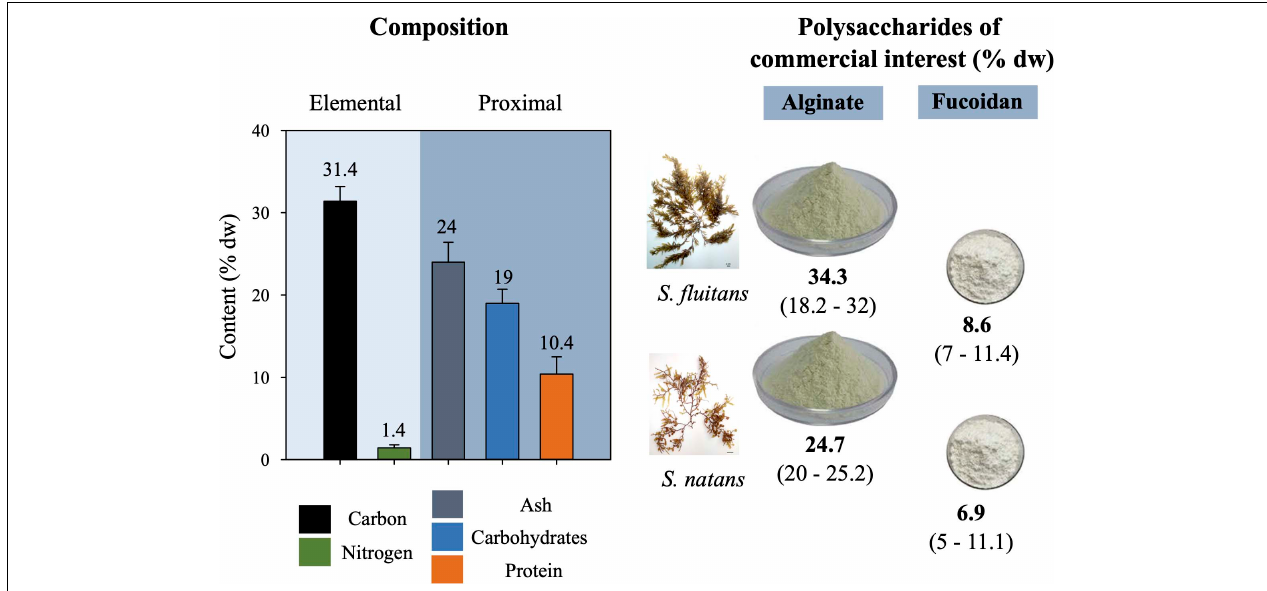
FIGURE 3 | Chemical composition of stranded biomass of Sargassum spp. from Mexican Caribbean. Elemental and proximal composition and commercial interest polysaccharides. Analysis from samples collected at Puerto Morelos, Quintana Roo, Mexico during 2018 Sargassum event. Values are reported with respect to the dry weight